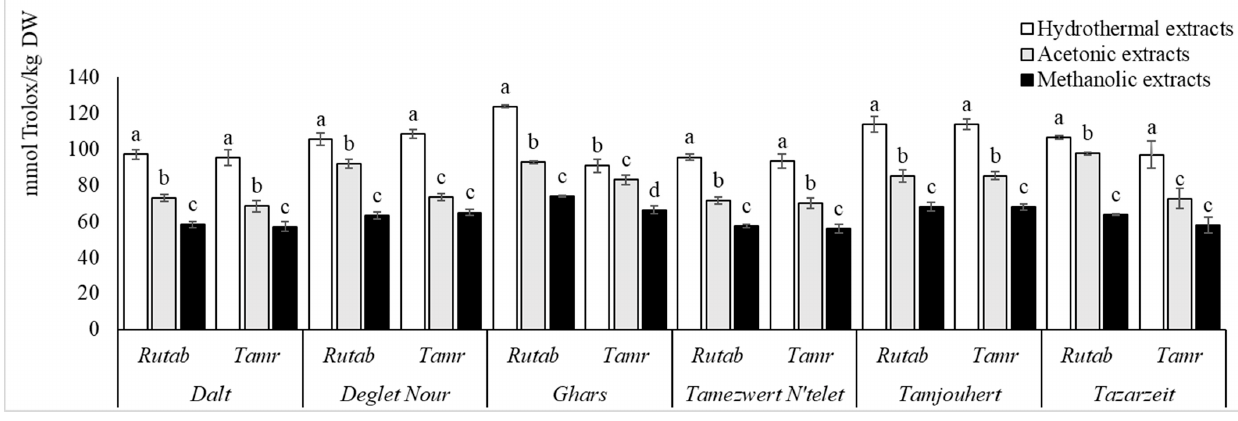
Figure 3. 2,2'-azino-bis(3-ethylbenzothiazoline-6-sulfonic acid (ABTS) scavenging capacity of all cultivars and ripe stages for the three extraction systems. Values are mean ± SD. Different letters indicate that the results are statistically different ( p < 0.05, b < a ).